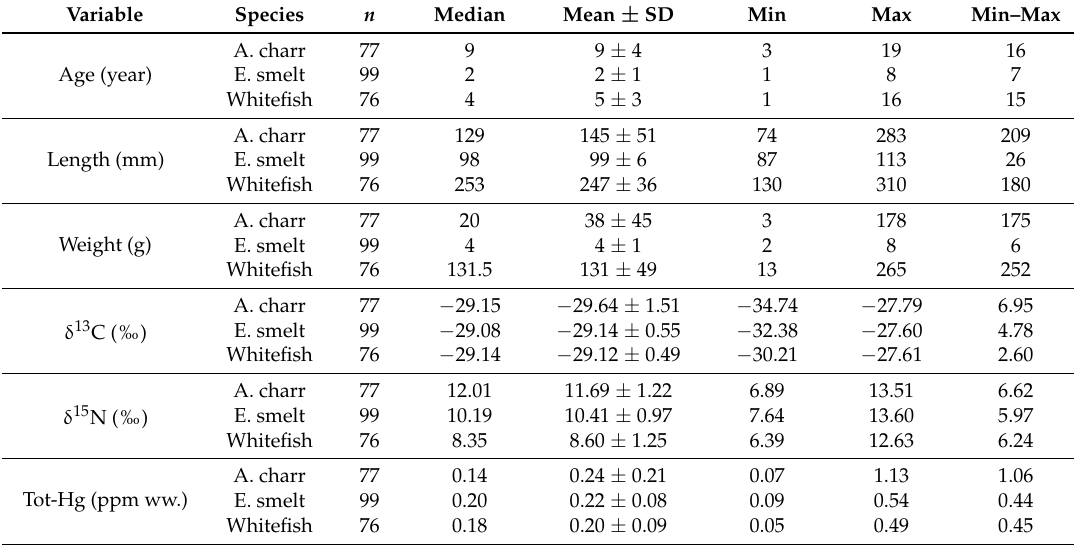
Table 2. Descriptive statistics for A. charr, E. smelt and whitefish including the variables age, length, weight, δ 13 C, δ 15 N and Tot-Hg